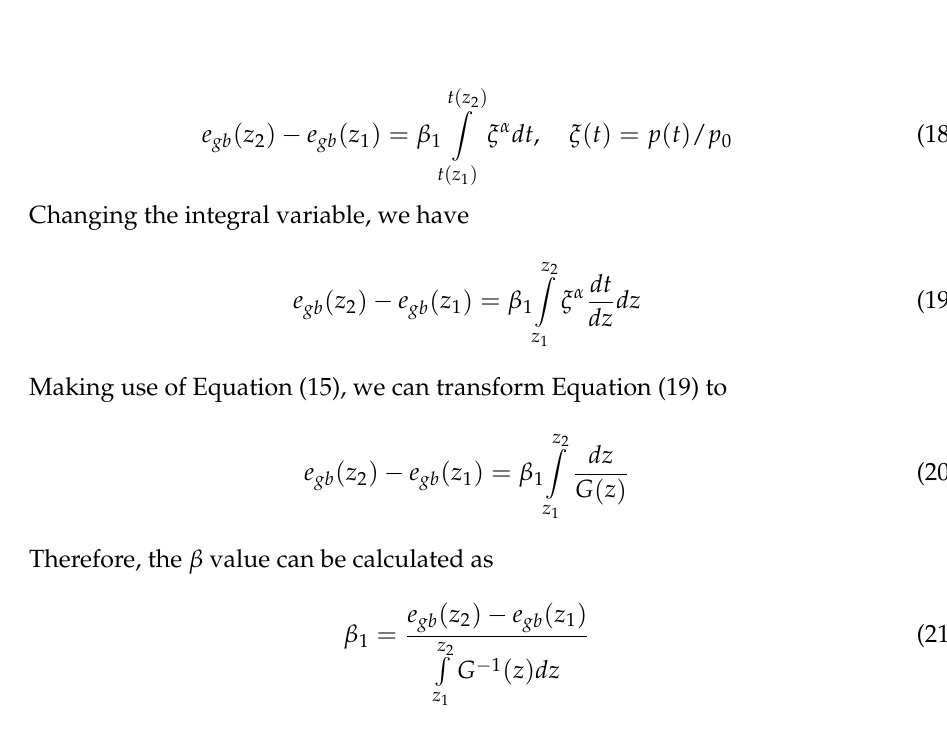
z values. Dashed lines represent the linear approximation. Points along a given line correspond to different values of ∆ . The slopes of the approximation lines are